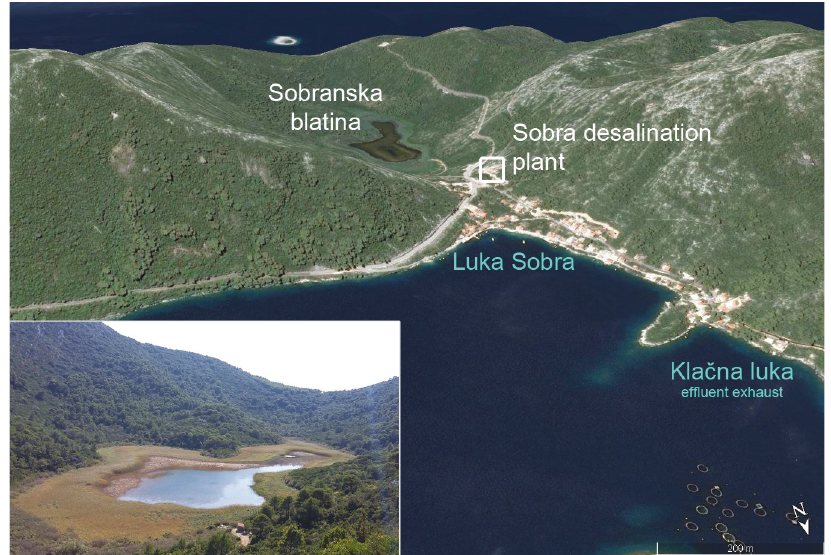
Figure 7: Elements of Sobra desalination system (satellite imagery adopted from Google Earth), with embedded photograph of Sobranska blatina taken from the location of a desalination plant in September 2016 in the bottom-left